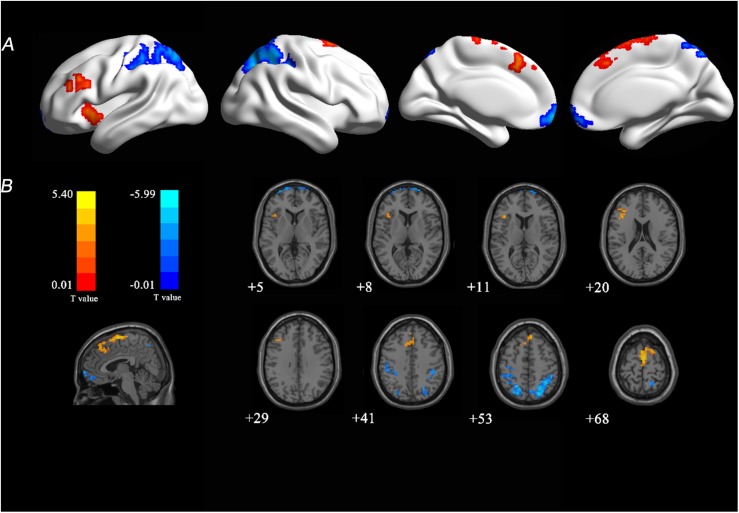
T-statistical FCS map at 4-year follow-up compared with baseline. (A) Longitudinal changes were overlaid on three-dimensional standard brain. (B) Longitudinal changes were overlaid on two-dimensional standard brain. Warm colors (red and yellow) represent increased FCS and cool colors (blue) represent decreased FCS with age. FCS, functional connectivity strength; T, statistical value.